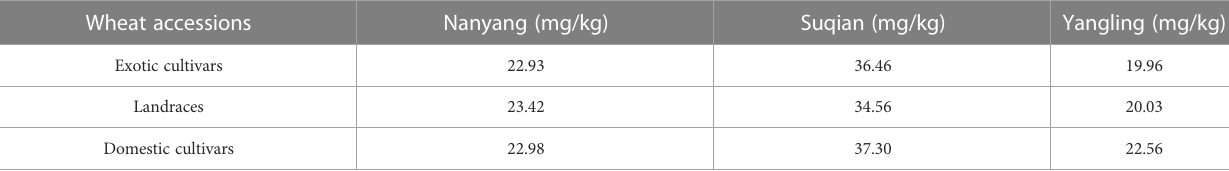
TABLE 2 GZnC of different source in three environments.